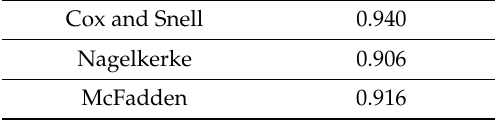
Table 3. Pseudo R-square test of discriminant groups, using the Nagelkerke function.